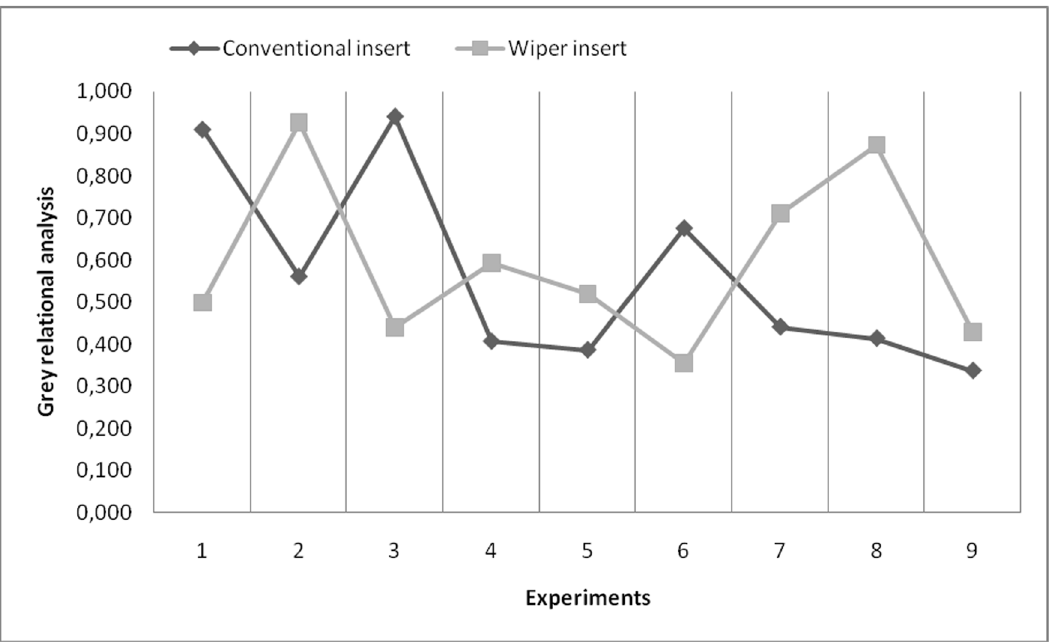
Figure 4: GRA for experiment